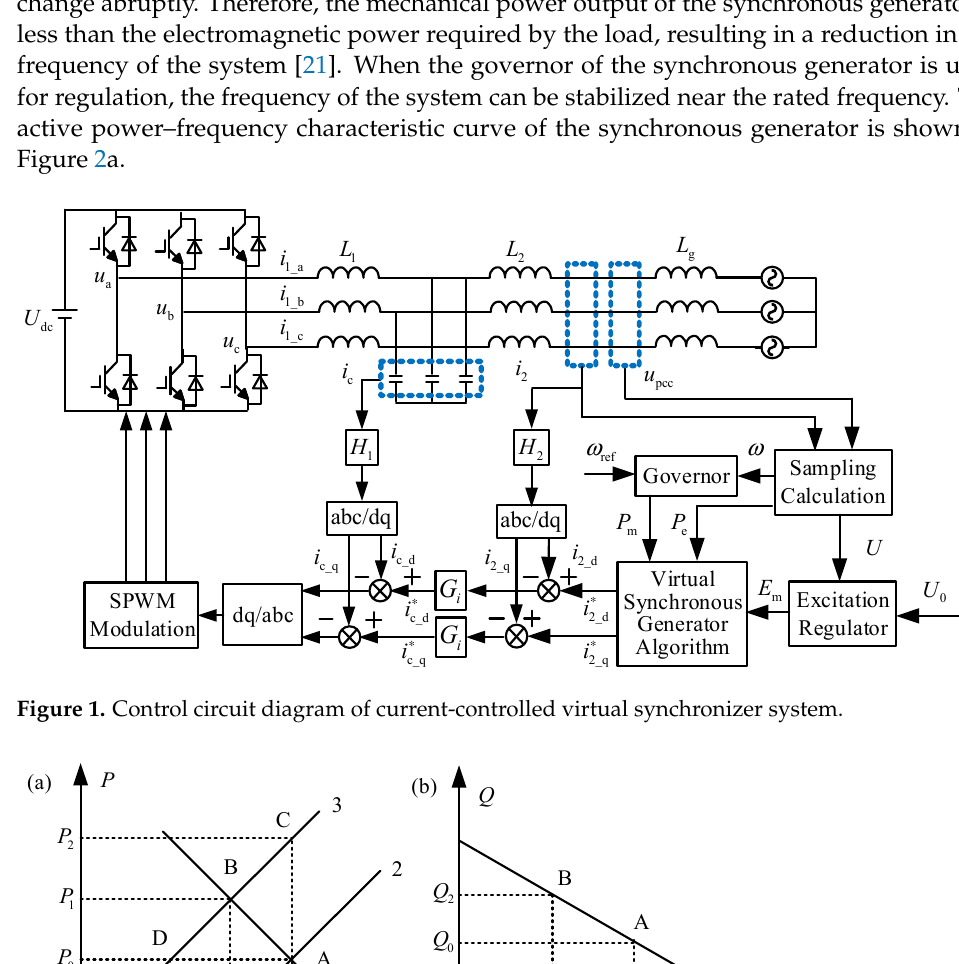
Figure 2. Characteristic curve of synchronous generator. ( a ) Active power–frequency characteristic curve; ( b ) Reactive power–voltage static characteristic curve.